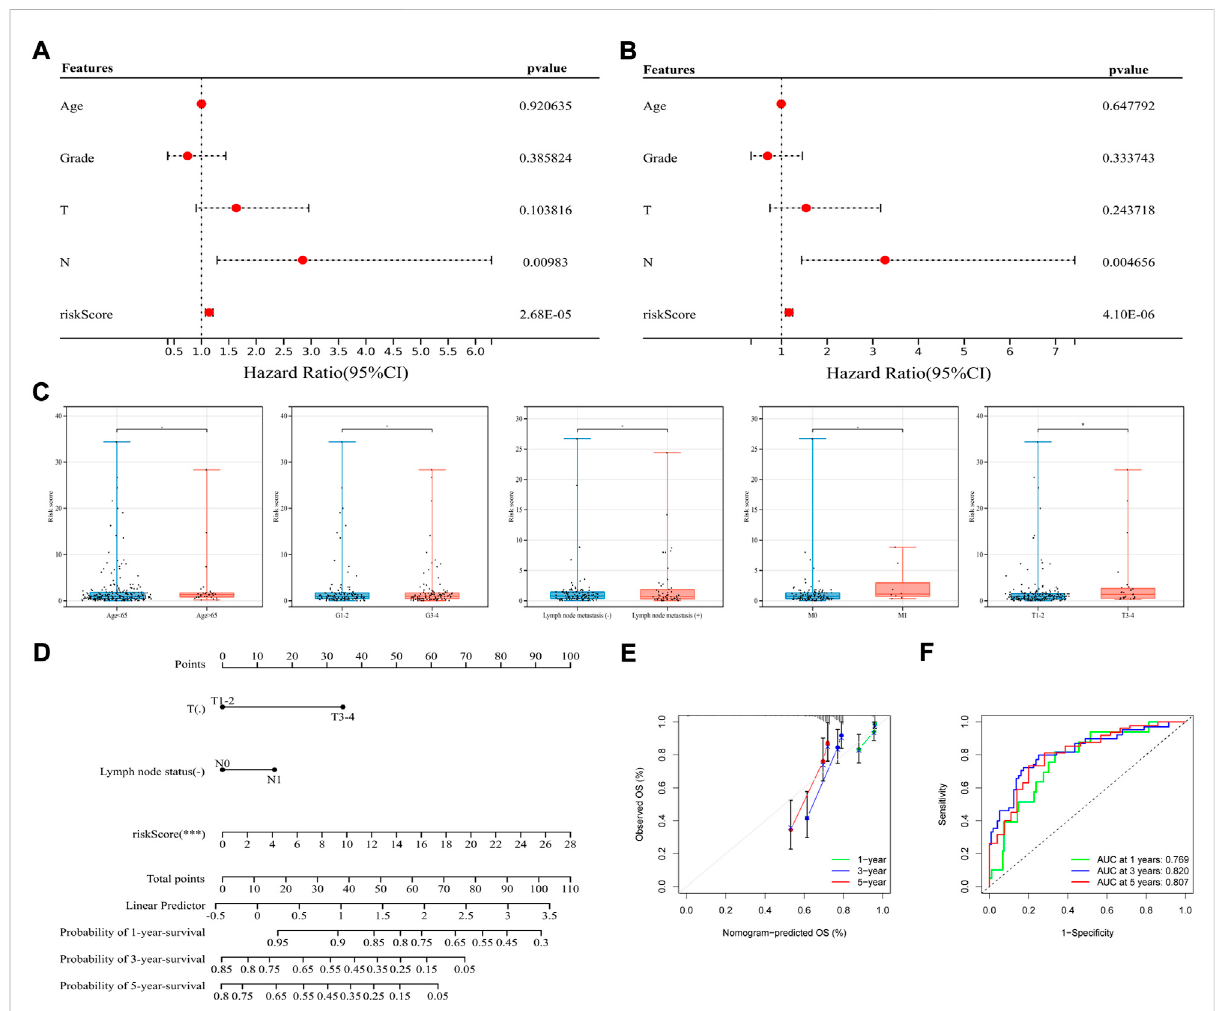
FIGURE 4 Application of the signature in classifying prognosis and clinicopathological features. (A,B) Univariate (left) and multivariate (right) Cox regression analysis in the whole TCGA-CSCC set. (C) Association between the signature and clinicopathological features, from left to right are age (the cut-off point is 65 years old), histological grade, lymph node metastasis, distant metastasis and T stage. (D) Construction of a nomogram integrated with clinicopathological characteristics. (E) The calibration curves based on the OS probability predicted by nomogram. (F) ROC curves of the whole TCGA-CSCC set corresponding to 1-, 3-, and 5-year OS based on the